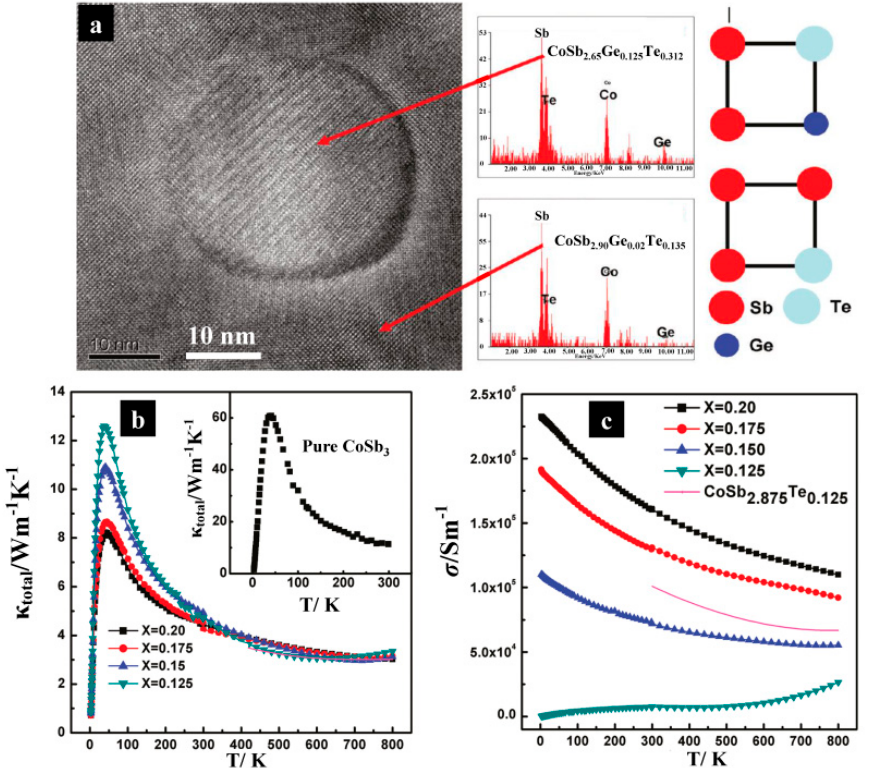
Figure 4. ( a ) Nanostructure consisting of circular shapes produced in situ inside the material; ( b ) tem- perature dependence of thermal conductivity and ( c ) electrical conductivity for CoSb 2.75 Ge 0.25 − x Te x (x = 0.125~0.20)